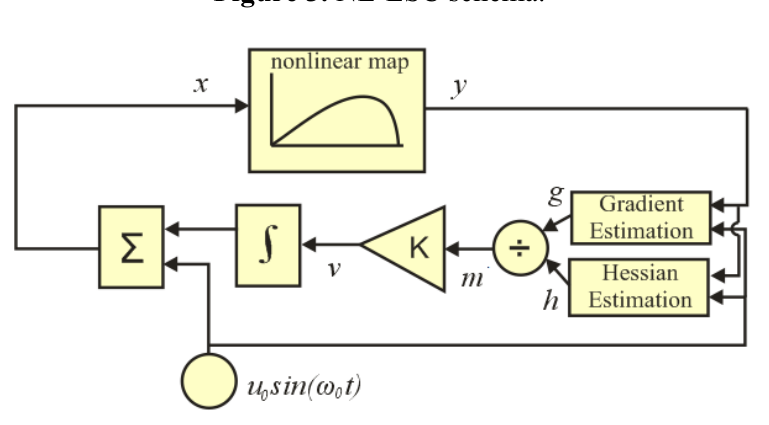
Figure 3. NL-ESC